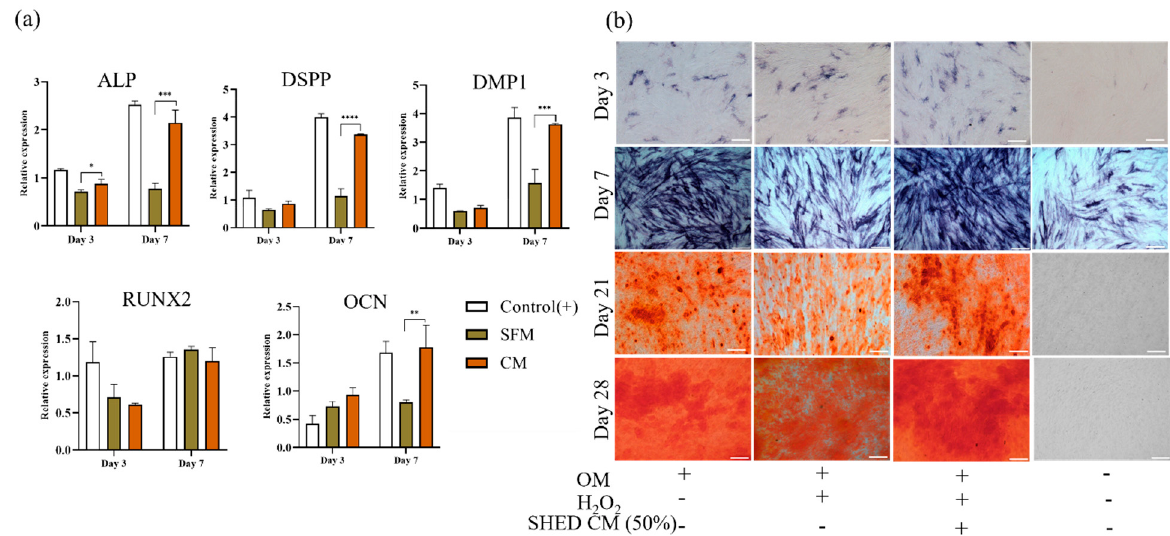
Figure 5. SHED CM enhanced DPSC osteogenic differentiation after exposure to 25 µ M H 2 O 2 for 24 h. ( a ) Relative gene expression, early marker at Day 3 and late marker at Day 7. ( b ) Alkaline phosphatase (ALP) and Alizarin red staining of DPSCs cultured in osteogenic differentiation media (OM) and 50% CM or SFM at Days 3, 7, 21 and 28. DPSCs cultured in growth media ( α MEM, 10% FBS, 1% PS) were used as a negative control. At day 7, the upregulation of ALP activity expressed darker blue in SHED CM treatment. The red color of ARS showed stronger in SHED CM group due to the increase in the amount of mineral deposition, compared to SFM at day 21 and 28. All data are represented as the mean ± SD. The statistical significance was calculated using one-way analysis of variance (ANOVA) to compare groups. Represents * p < 0.05, ** p < 0.01, *** p < 0.001, **** p < 0.0001, ns = nonsignificant, scale bar = 200 µ